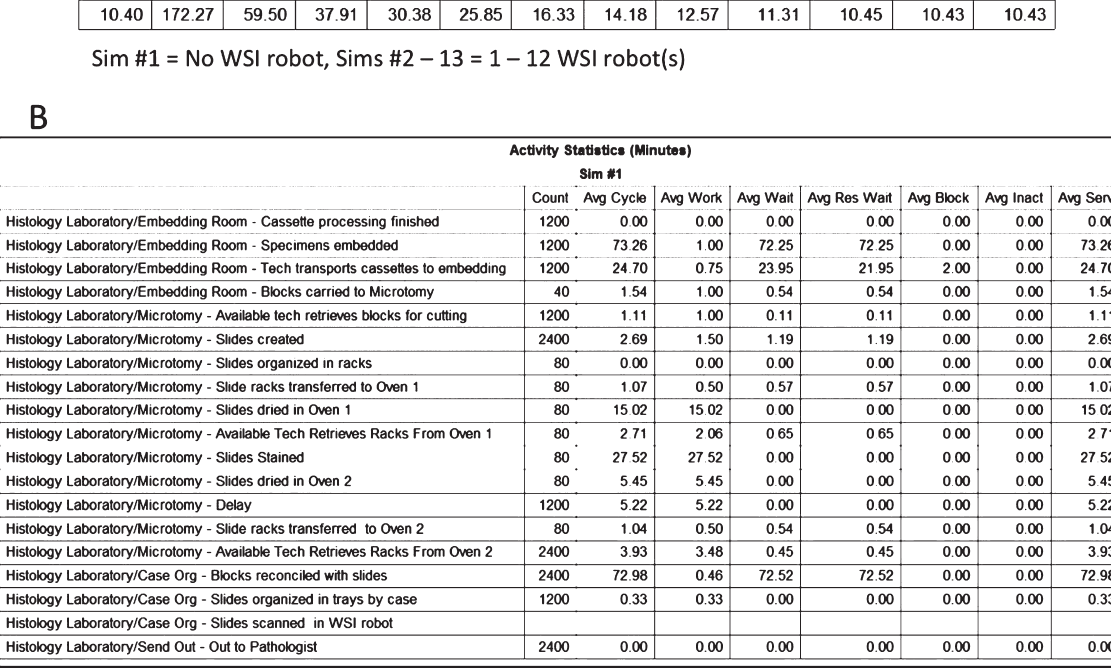
Fig. 2. (A) Simulation data, Total Process Time, (B) Individual Process Statistics Without WSI Robot, (C) Individual Process Statistics With One WSI